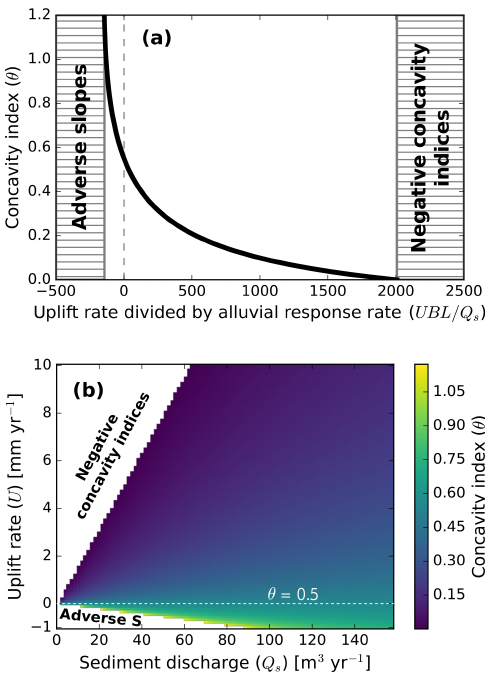
Figure 7. Concavity changes uplift (or subsidence) rates increase when compared to a characteristic alluvial response rate. (a) As in Fig. 3, increasing uplift rates decrease the channel concavity in- dex. Here we vary channel width, sediment discharge, and uplift, and demonstrate how channel concavity change follows the ratio of uplift rate, the external driver, to the internal system response rate (Eq. 56). We disallow solutions that produce adverse slopes (these occur with high subsidence) or negative concavity indices (these occur with high uplift rates), as the former break the assumptions of our equations and the latter are not observed steady-state forms in nature. Changes in the valley-width exponent, P x,B , change the shape of this curve by modifying the downstream distribution of val- ley widths and therefore altering the local alluvial response rates; all calculations for both panels were performed using P x,B = 1. (b) For a single mean valley width (177m), we compare the con- cavity index against the ratio of sediment discharge to uplift rate. It is important to note that with no uplift, concavity is constant at θ = 0 . 5 regardless of sediment discharge.